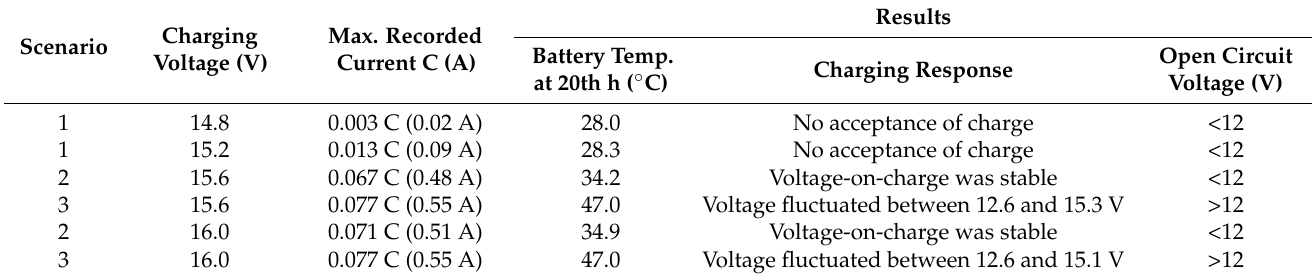
Table 4. Charging results for the failed batteries charged at high charging